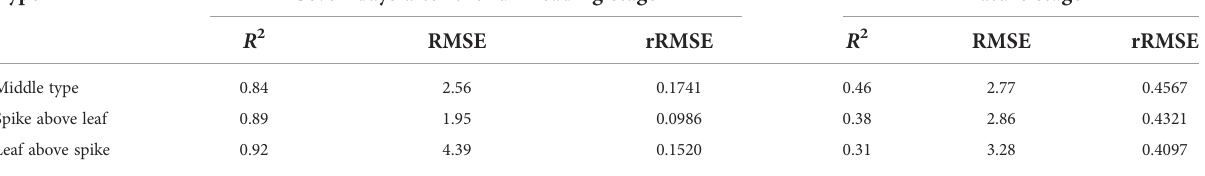
TABLE 6 The accuracy of our method for identifying different types of panicles.